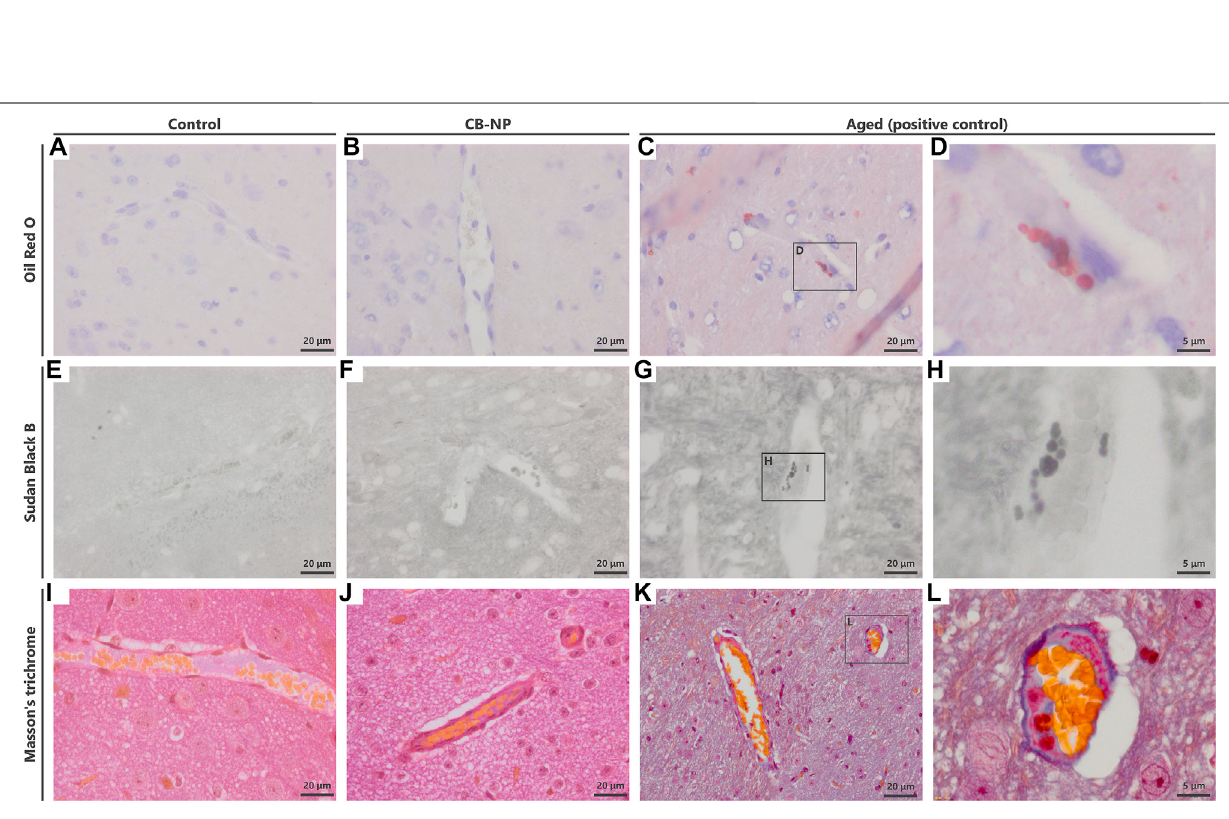
Frontiers in Toxicology |